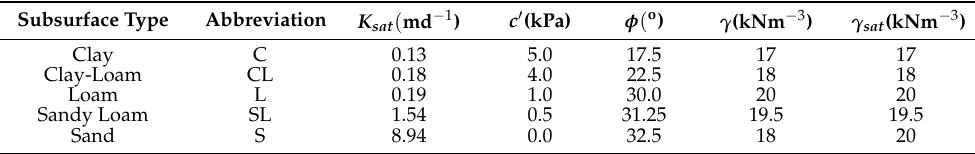
Table 2. Subsurface types used in the model, related to the D typ , U typ and L typ parameters. The subsurface type is linked to the hydraulic conductivity ( K sat ), drained cohesion ( c (cid:48) ), effective friction angle ( φ ), the bulk unit weight ( γ ) and the saturated bulk unit weight ( γ sat